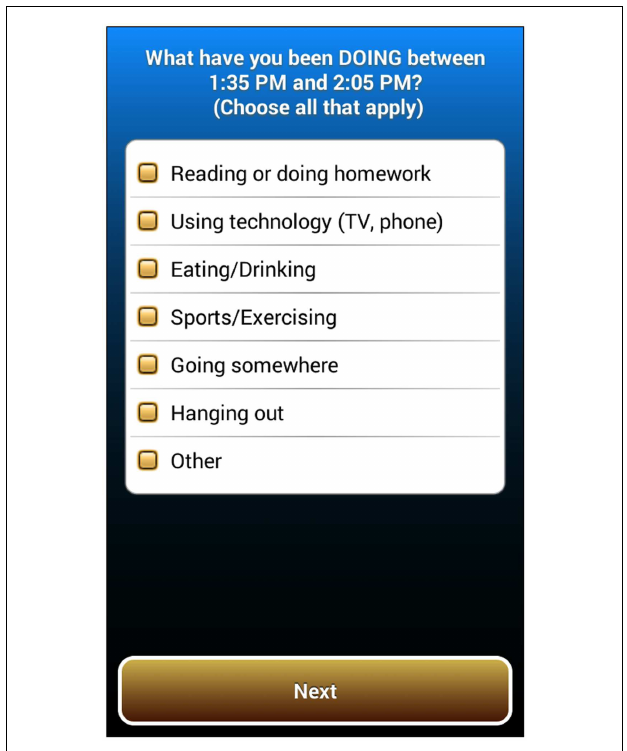
FIGURE 1 | Screenshot of the initial activity type question for the sensor-informed context-sensitive ecological momentary assessment (CS-EMA) component